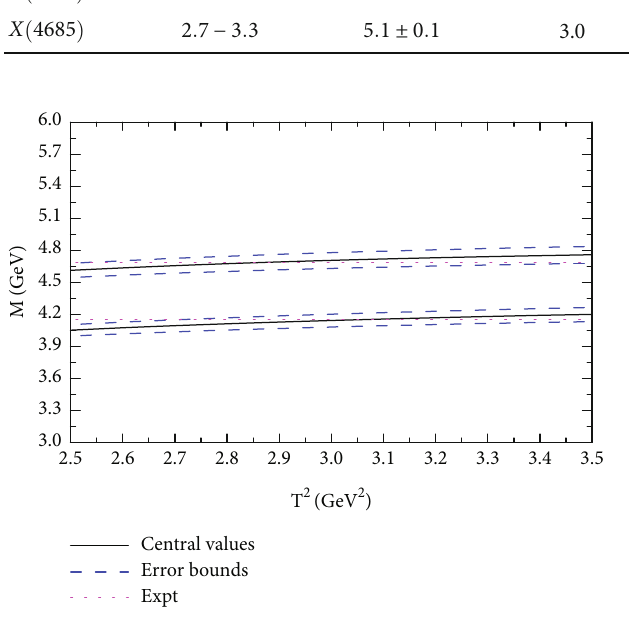
Figure 1: The masses of the X and X ′ with variations of the Borel parameter T 2 , where the expt stands for the experimental values of the masses of the X ð 4140 Þ and X ð 4685 Þ ,